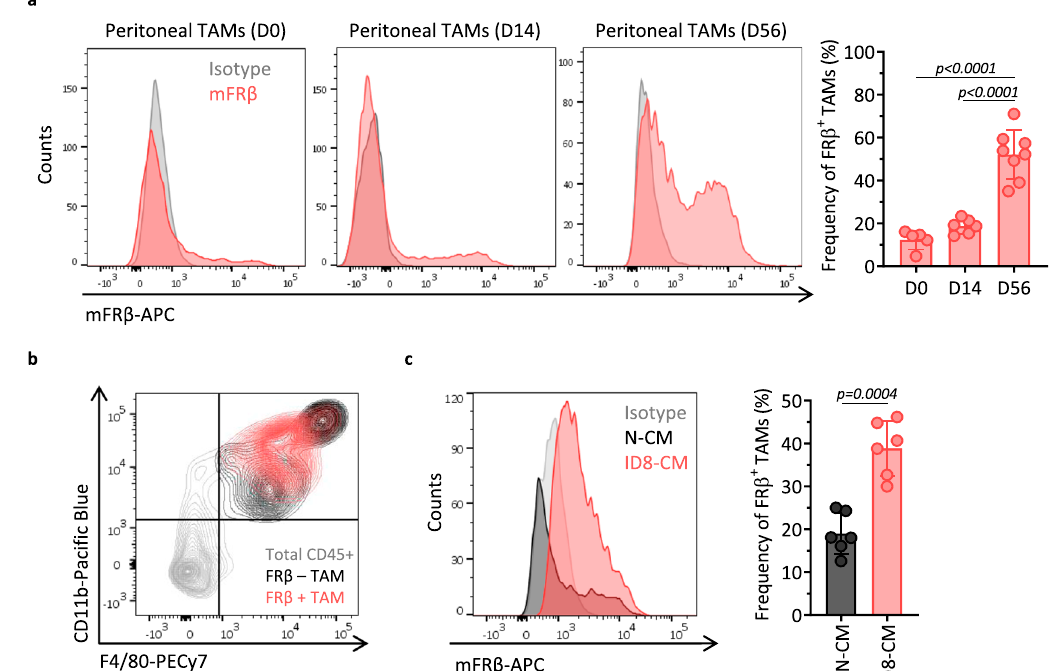
Fig. 1 FR β is expressed by TAMs in the ovarian cancer TME. a mFR β expression in peritoneal TAMs from ID8 ovarian tumor-bearing C57BL/6 mice obtained at indicated time points after i.p. tumor inoculation. Representative histograms (gray – isotype, red – anti-mFR β , left panel) and frequency of FR β + TAMs (de fi ned as live, CD45 + CD11b + F4/80 + cells, right panel) are shown. Mean± SD are represented ( n = 5 mice for D0, 6 for D14, and 8 for D56 groups). b Representative fl ow plot demonstrating the gating strategy for TAMs by looking at CD11b ( Y -axis) and F4/80 ( X -axis) expression. Total CD45 + cells are depicted in gray, FR β + population of TAMs in red, and FR β − TAMs in black. c FR β expression in peritoneal macrophages obtained from tumor-free mice and exposed for 72 h to nonconditioned media (N-CM) or ID8-conditioned media (ID8-CM). Representative histograms (gray — isotype, black — N- CM, and red — ID8-CM, left panel) and frequency of FR β + macrophages (de fi ned as live, CD45 + CD11b + F4/80 + cells, right panel) are shown. Mean± SD from two pooled independent experiments is represented ( n = 6 mice). P values by a one-way ANOVA with Tukey ’ s multiple comparison test and c a two- tailed paired t test are indicated. Source data are provided in the Source Data fi